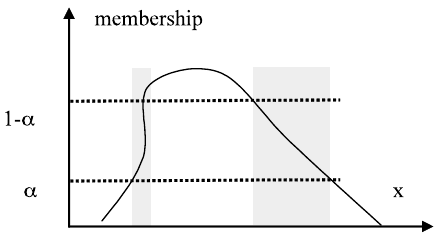
Figure 11. The concept of a shadowed set induced by some fuzzy set; note the range of membership grades (located between α and 1- α ) generating a